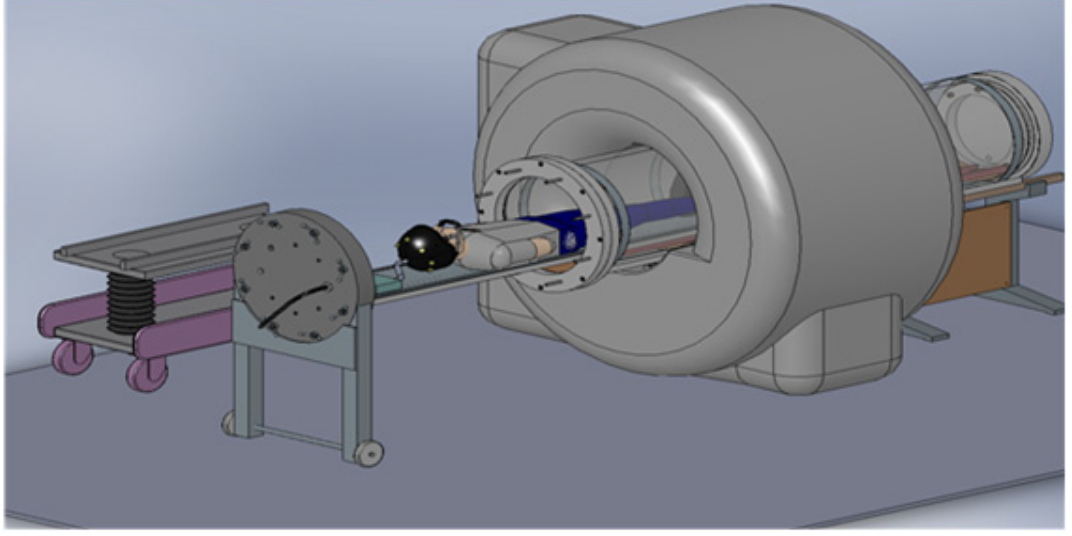
Figure 1. The proposed hyperbaric MRI compatible chamber and the general layout.